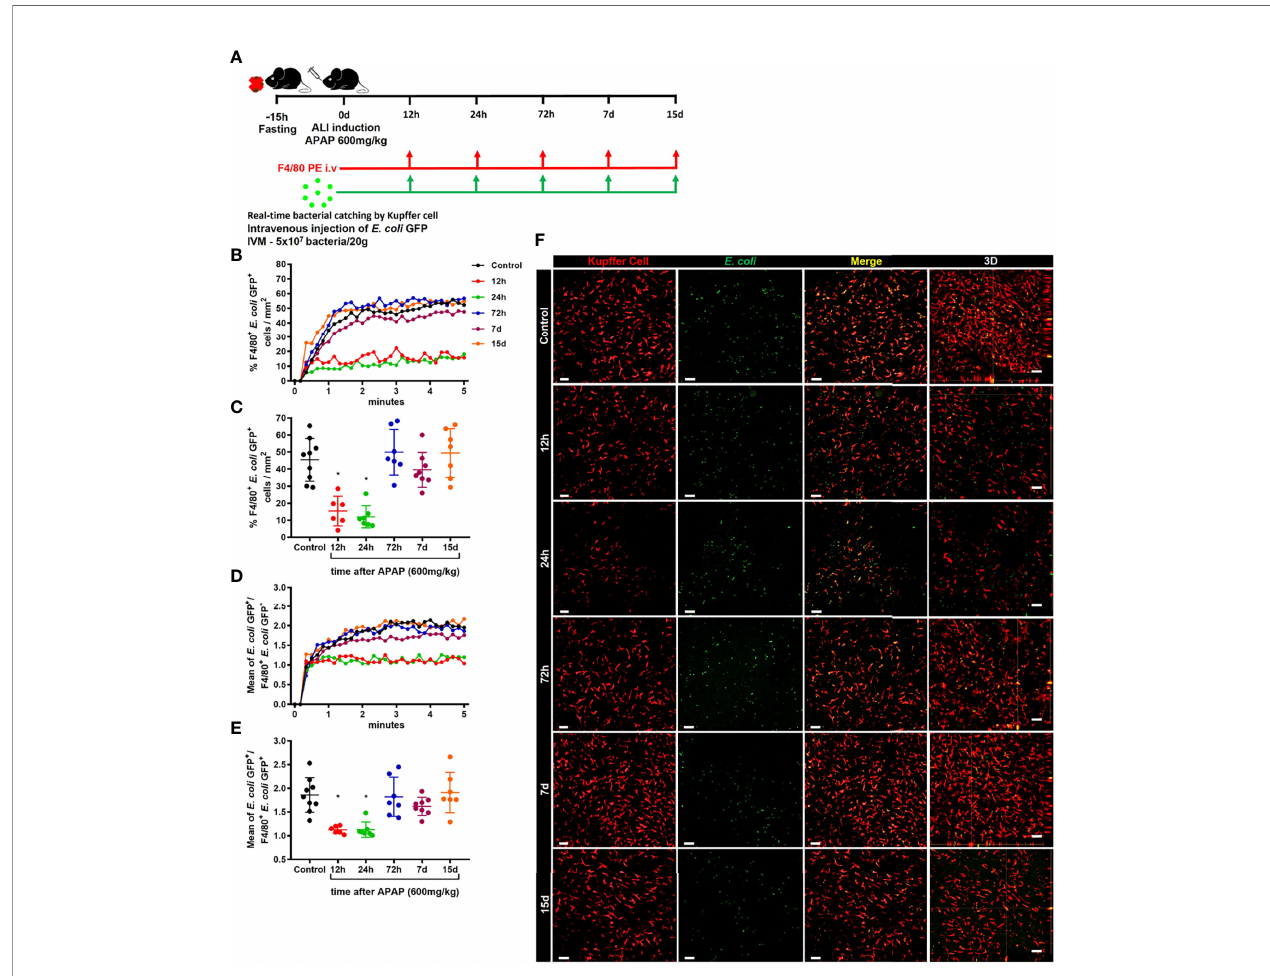
FIGURE 7 | Kupffer cell phagocytic ability is strongly reduced in the early stage of ALI. (A) Scheme of real-time E. coli phagocytosis by Kupffer cells in 5 minutes after i.v injection of 5x10 7 bacteria/20g. Measurement of real-time E. coli phagocytosis by Kupffer cell every 10 seconds during the fi rst 5 minutes (B) after injection and at the end of 5 minutes (C) ; n ≥ 6 mice per group; representative of 2 independent experiments. Mean of E. coli GFP + numbers per Kupffer cell GFP + quanti fi ed during the fi rst 5 minutes (D) after injection and at the end of 5 minutes (E) ; n ≥ 6 mice per group; representative of 2 independent experiments. (F) Representative images at minute 5 and 3D slice (fourth column) for each group; E. coli is green; Kupffer cell is stained by anti-F4/80 PE (red) and E. coli merged with Kupffer cell in yellow; scale bar = 50 µm. Data are presented as mean ± SD. * indicates statistical difference compared to the control group using one-way ANOVA followed and Tukey post-test (* = p <